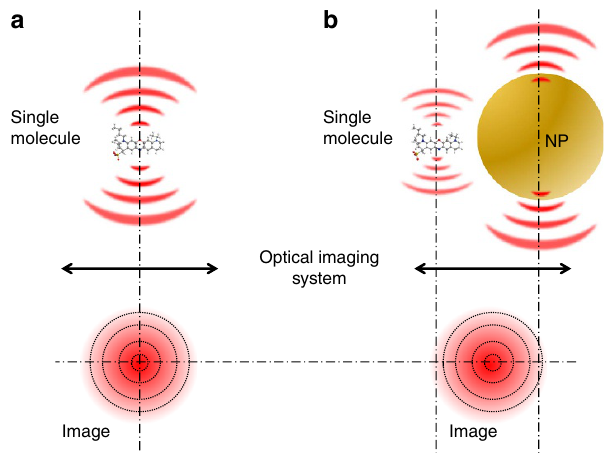
Figure 1 | Schematic representation of the single-molecule mirage induced by a metallic nanoparticle (NP). ( a ) The image of an isolated molecule is centred at the position of the molecule. ( b ) Imaging of a single molecule coupled to a metallic nanoparticle in the near-field leads to an image that may correspond neither to the position of the molecule nor to the position of the